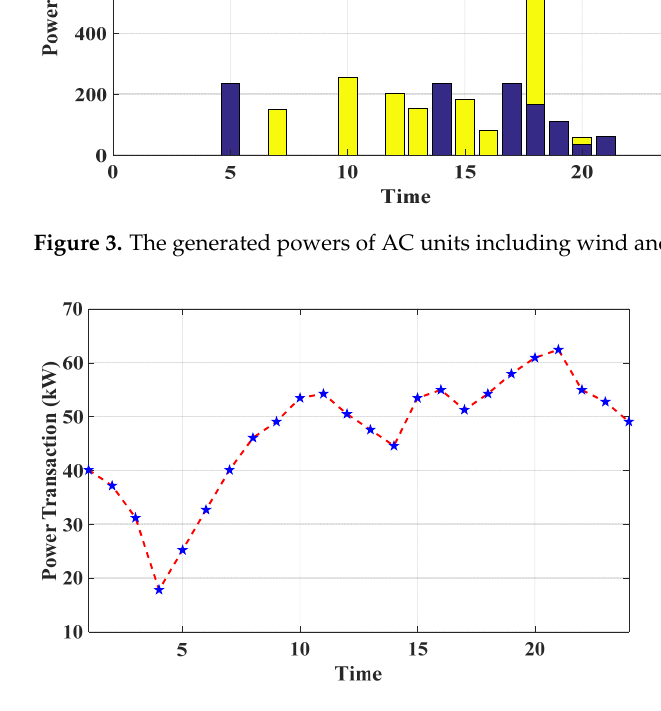
Figure 4. The power exchanged between the grid and the hybrid microgrid.